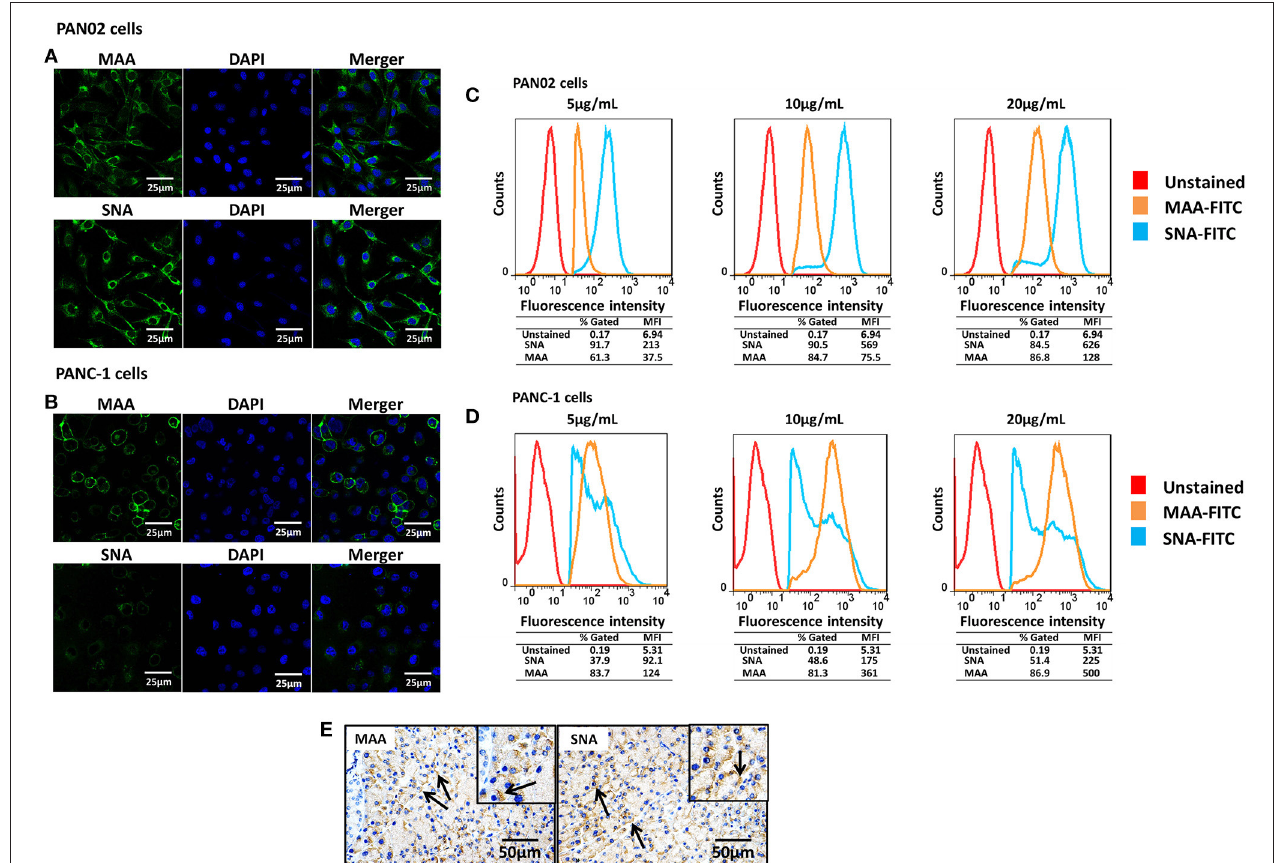
FIGURE 1 | Pancreatic cells express α -2,3- and α -2,6-linked sialic acid (SA) receptors. (A,B) The pancreatic cell lines PAN02 and PANC-1 were placed on polylysine-coated slides and stained with fluorescein isothiocyanate (FITC)-conjugated Sambucus nigra bark lectin (SNA) or Maackia amurensis lectin I (MAA-I) (green), and 4 ′ ,6 ′ -diamidine-2-phenylindole (DAPI; blue) for nuclei. (C,D) Trypsinized PAN02 and PANC-1 cells were incubated with FITC-conjugated SNA or MAA-I (concentrations from left to right are 5, 10, and 20 µ g/mL) and analyzed using flow cytometry to determine the relative percentages of cells expressing α -2,3-SA (MAA, yellow) or α -2,6-SA (SNA, blue) compared to unstained cells (red). (E) Representative pancreas sections from mock-treated mice were analyzed by immunohistochemical staining using SNA and MAA-I antibody, respectively. Black arrows indicate positive signals.